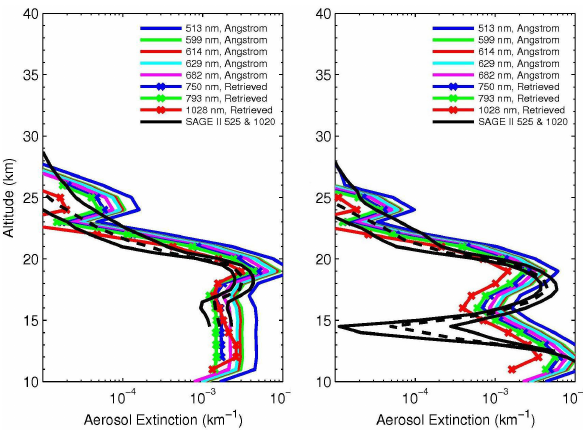
Fig. 12. Plot of the retrieved SCIAMACHY vs. SAGE II aerosol profiles, similar to Fig. 10 left panel, but for 13 September 2004, latitude 60.9 ◦ S and longitude 81.2 ◦ W, and 9 September 2004, lat- itude 61.2 ◦ S and longitude 23.9 ◦ W respectively.